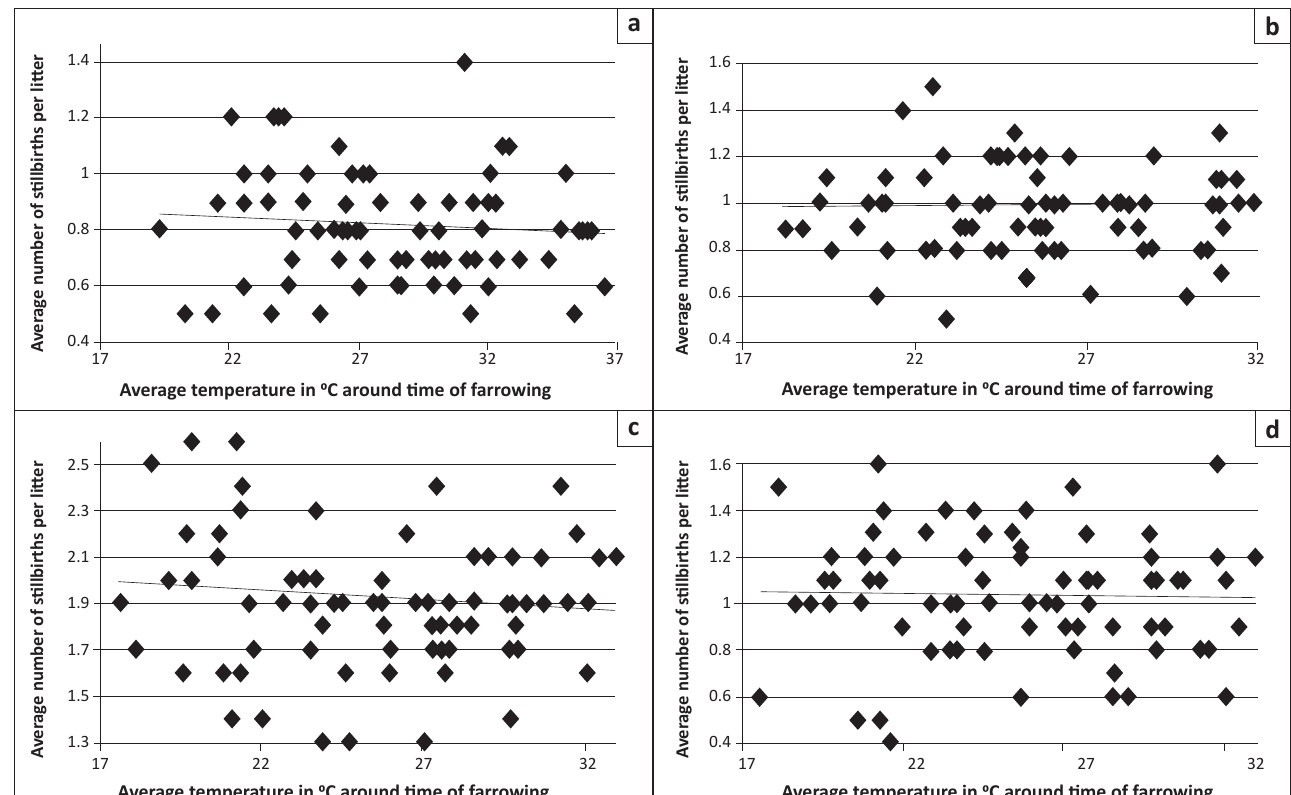
Average temperature in 0C around time of